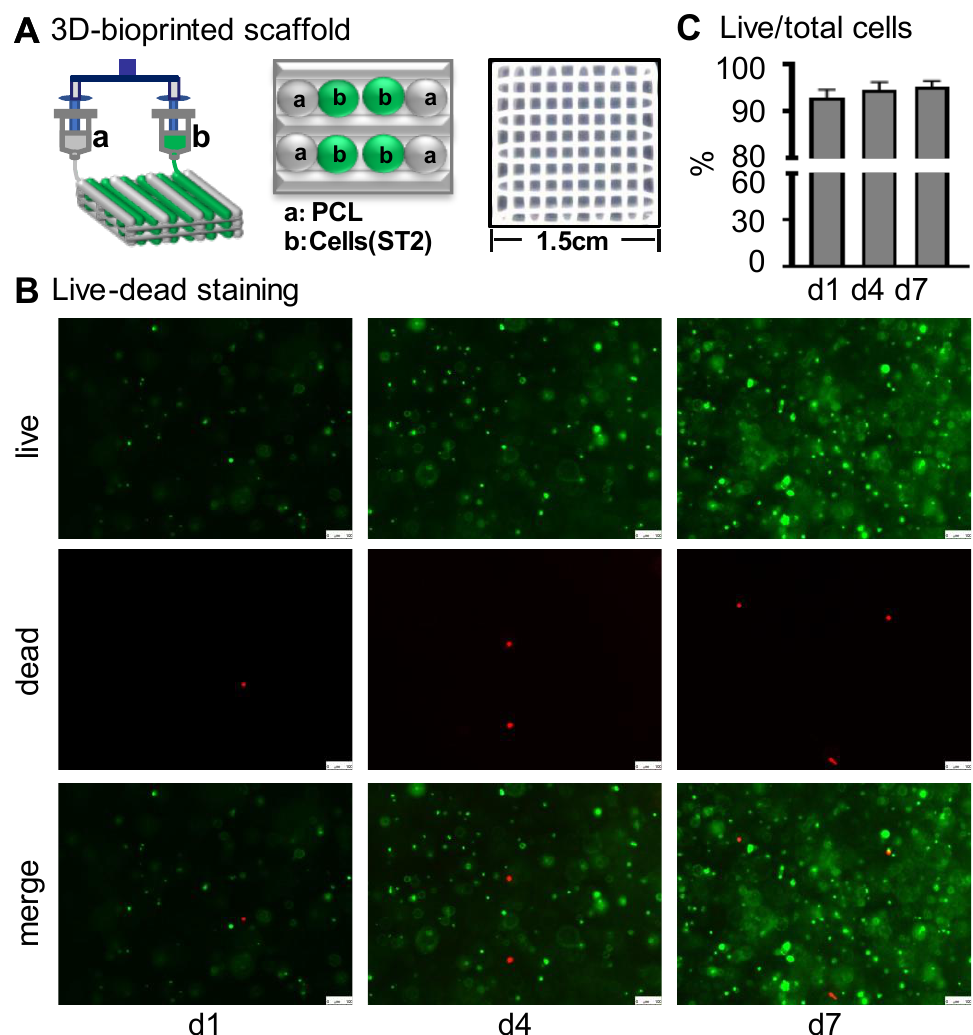
Figure 2. Preparation of ST2/GelMA/PCL 3D scaffold and its cell viability assay. ( A ) Schematic diagram of the 3D printing scaffold and gross pictures of the scaffold. ( B ) Fluorescence images of live/dead staining and ( C ) quantification of cell viability (the percentage between the number of living cells and total cells) in the Wnt3a pretreated scaffold on days 1, 4, and 7 (n = 3). Cell viability on days 1, 4, and 7 was not statistically different by one-way ANOVA. (Scale bar: B, 100 µm). GelMA, gelatin methacryloyl; PCL, polycaprolactone.